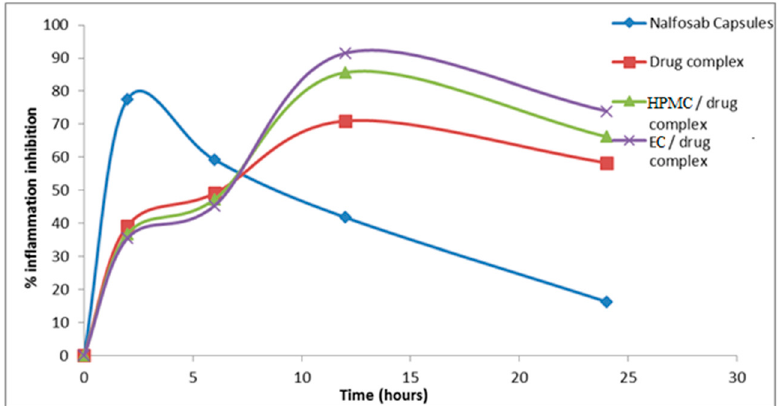
Figure 8. Mean % inhibition of induced inflammation by Nalfosab Capsules, drug complex, HPMC/drug complex and EC /drug complex.